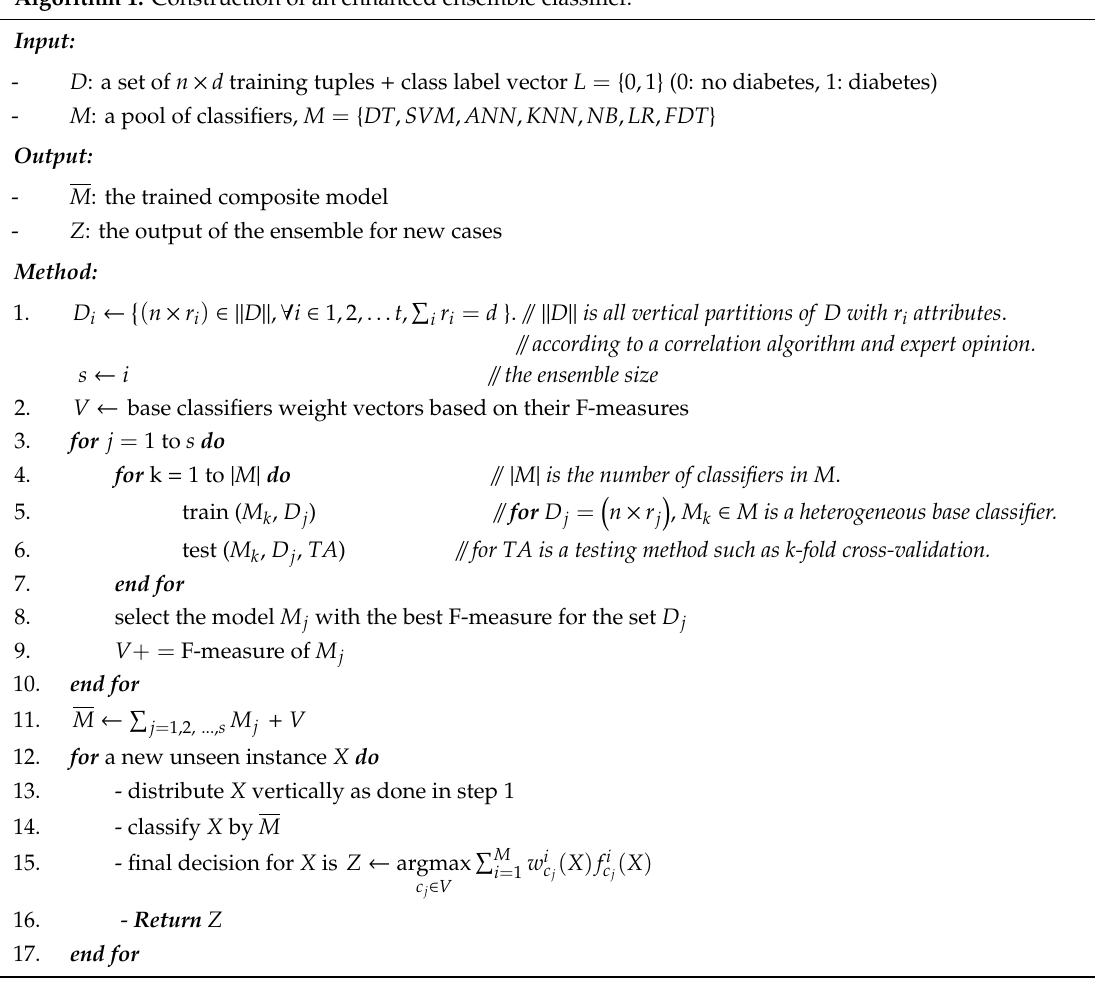
Algorithm 1. Construction of an enhanced ensemble